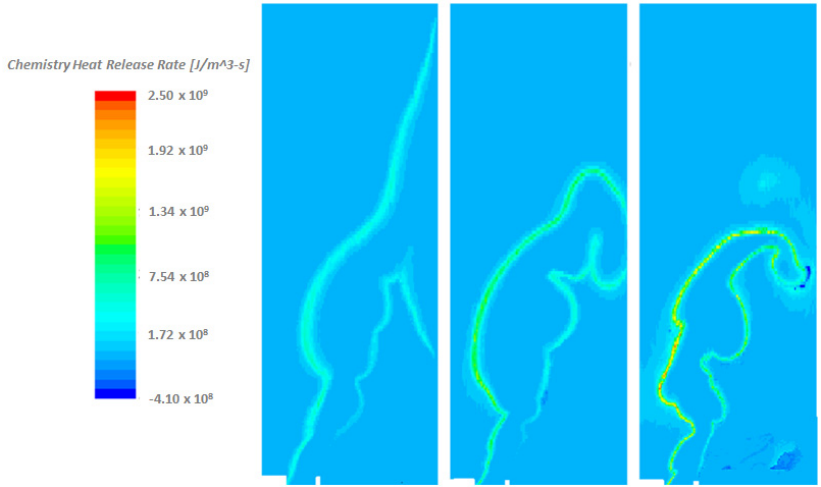
Figure 10. Instantaneous chemistry heat release rate. ( Left ) 20/80; ( Centre ) 40/60; ( Right ) 60/40 (vol%) methane/ammonia blends under stoichiometric conditions.